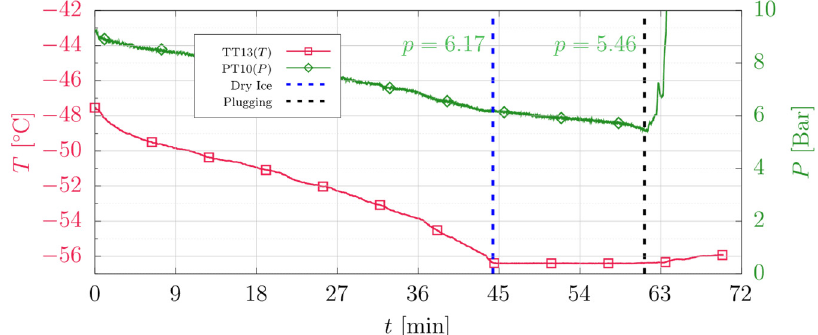
Figure 9. Pressure and liquid temperature in SV02 during Experiment 4. Table 6. Calculated values in TREND and experimental results for vapor, liquid, and gas phase fractions after expansion to the separation pressure in SV02 in Experiment 4. TREND Experimental Results